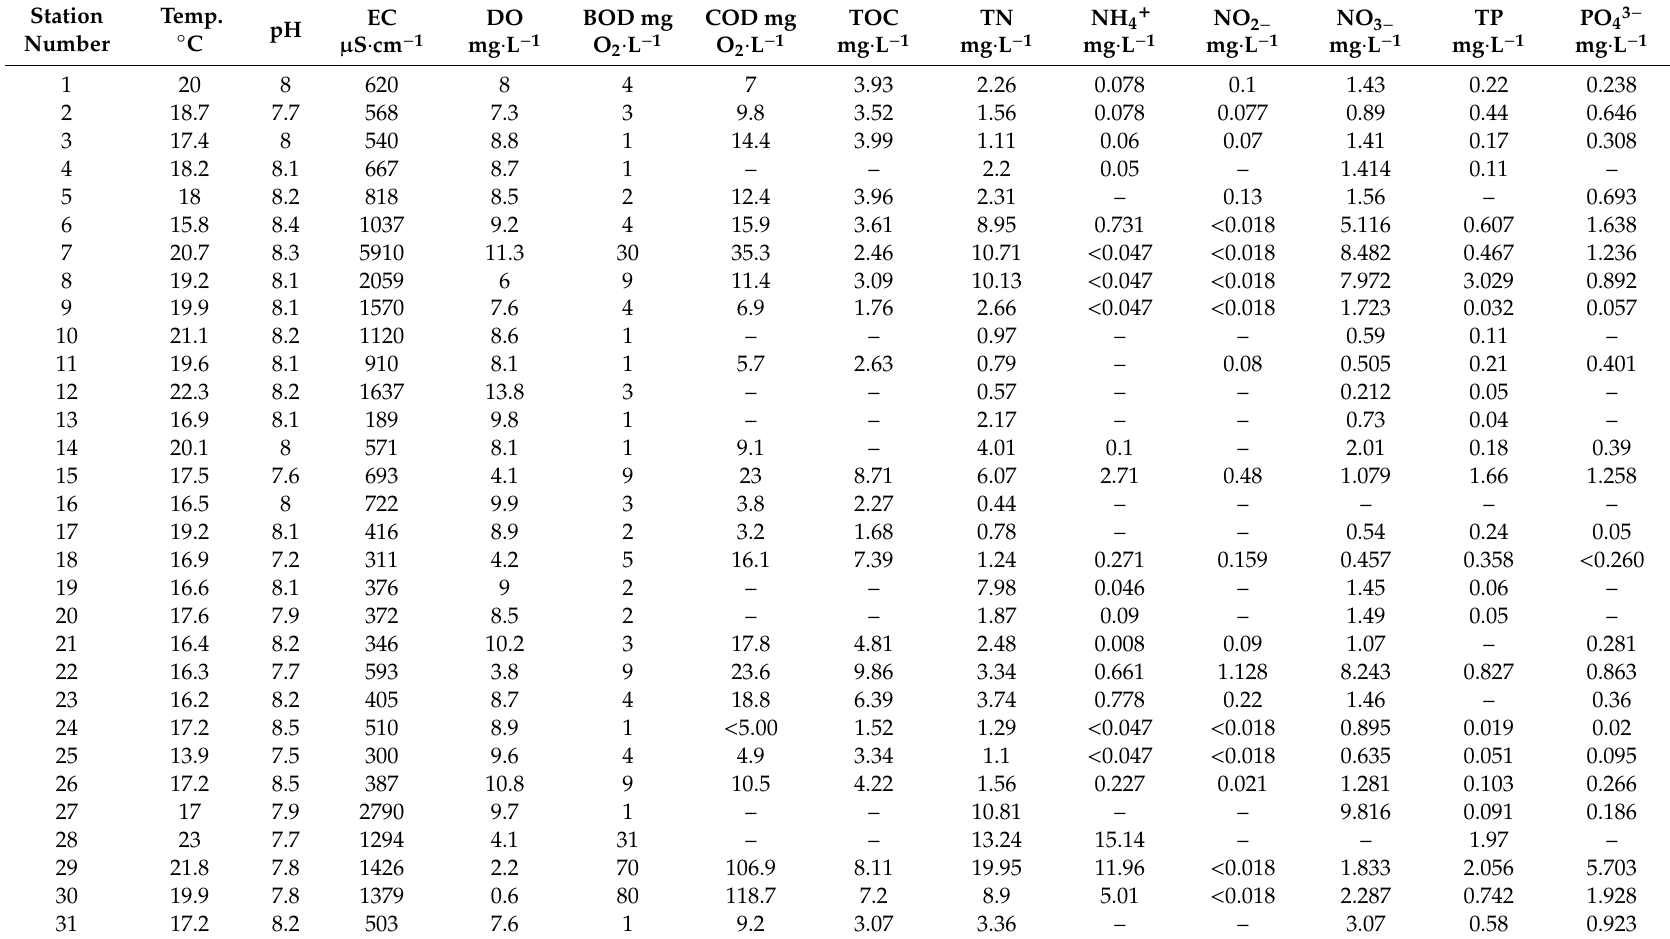
Table 3. The physico-chemical parameters of water studied: Temp.—water temperature, EC—electrolytic conductivity, DO—dissolved oxygen, BOD—biochemical oxygen demand, COD—chemical oxygen demand, TOC—total organic carbon, TP—total